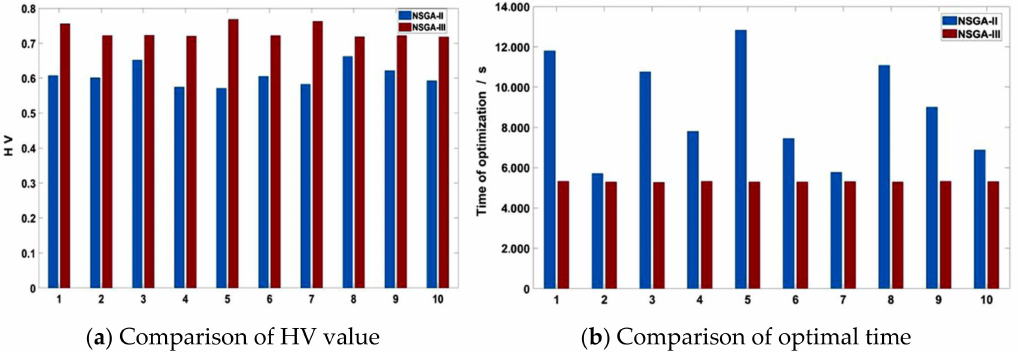
Figure 19. Performance comparison between NSGA-II and NSGA-III.